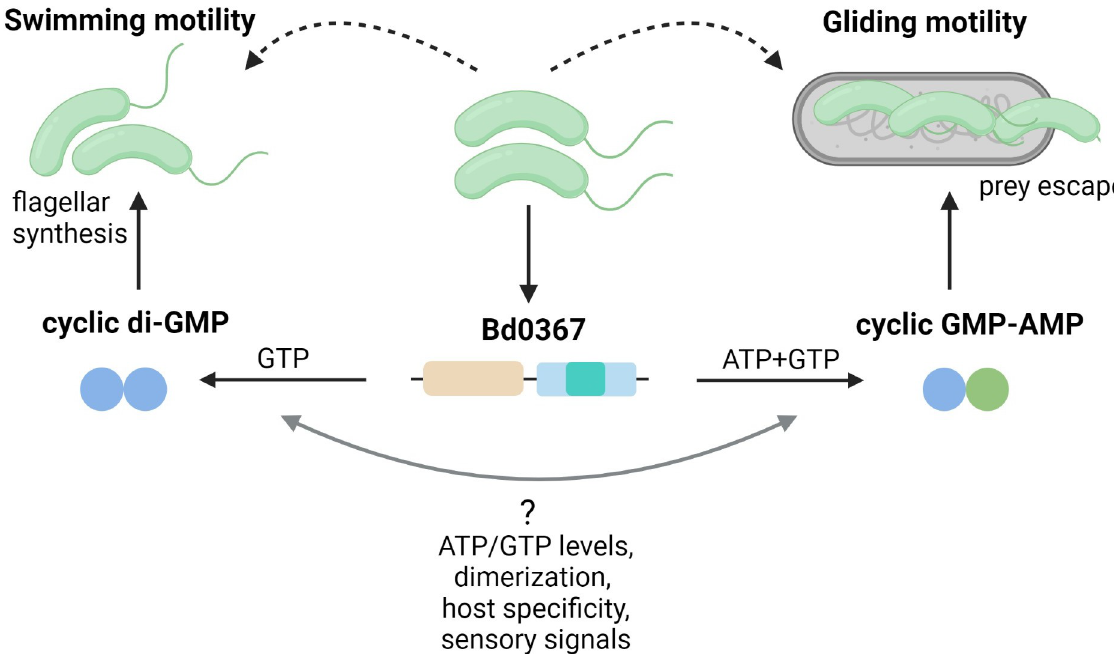
Fig 2. The dual role of Bd0367 in B . bacteriovorus . Bd0367 can produce cGAMP and c-di-GMP, which control gliding motility and swimming motility, respectively. The signals that regulate synthesis of c-di-GMP or cGAMP by Bd0367 are unknown.